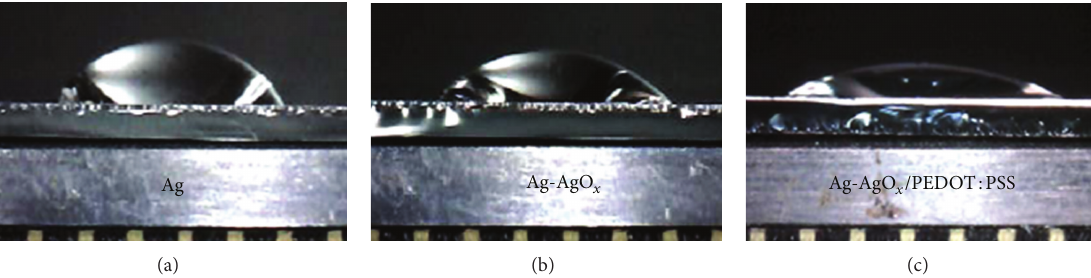
Figure 2: Static water contact angle on the surface of Ag, Ag-AgO 𝑥 , Ag-AgO 𝑥 /PEDOT:PSS thin films is 56 ∘ , 48 ∘ , and 31 ∘ , respectively.